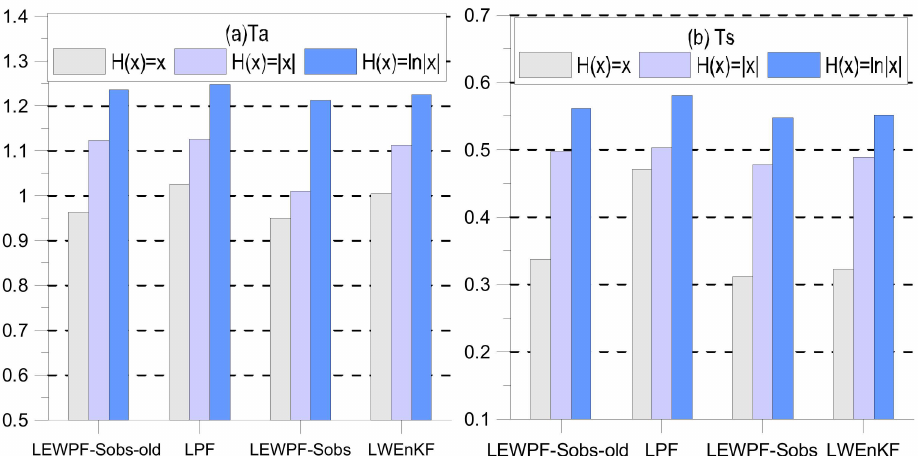
Figure 7. The annual average RMSEs of the data assimilation with LEWPF-Sobs, LPF, LEWPF-Sobs- old and LWEnKF with different observation operators. ( a ) The average RMSE of T a with different algorithms. ( b ) As ( a ) but for the T s